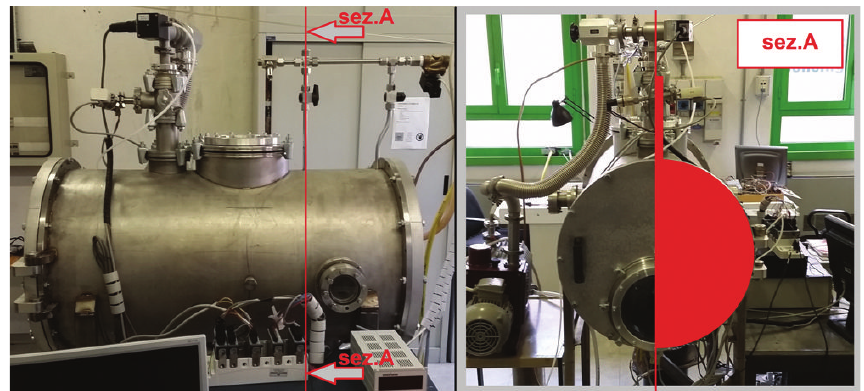
Figure 1: STARDUST facility picture showing the section (“sez.A”) that is implemented in the numerical simulation software, as shown in Figures 2, 3, and 4.